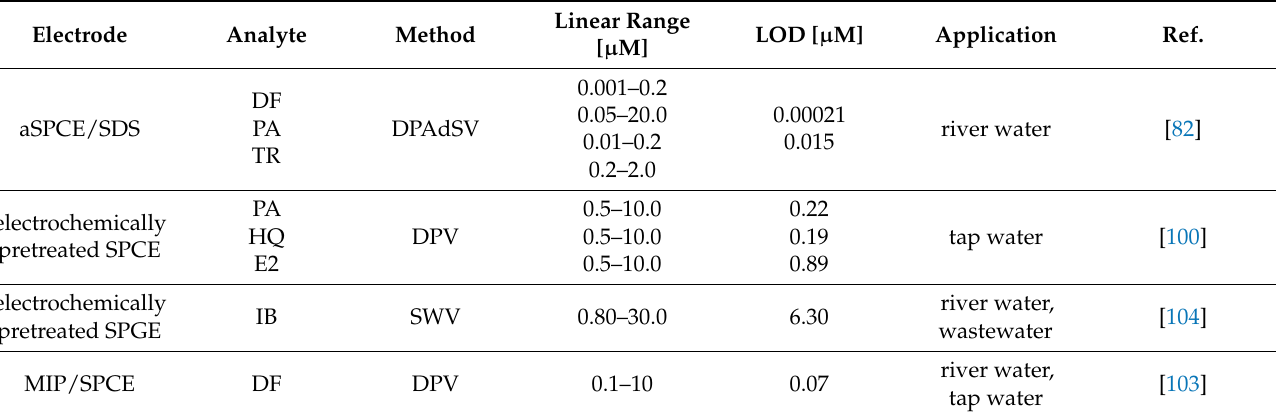
Table 3. Summary of voltammetric procedures for painkillers residues determination at the electro- chemically pretreated screen-printed electrodes or modified with polymer film in environmental water